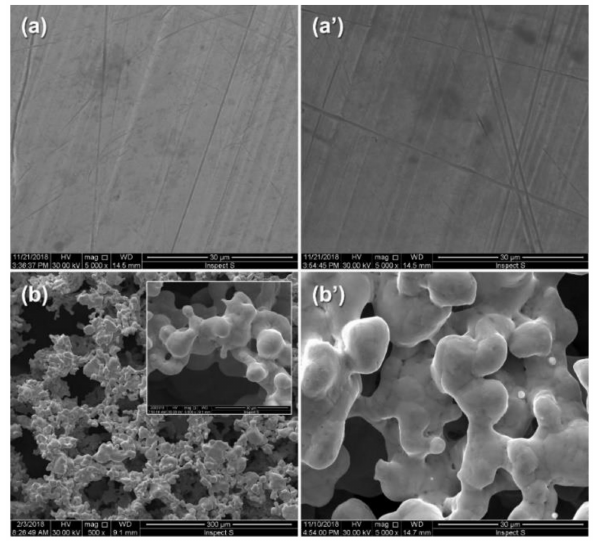
Figure 2. FESEM images of pristine Ag ( a ), pristine Ag-after reaction ( a’ ), Ag foam ( b ) and Ag foam-after reaction ( b’